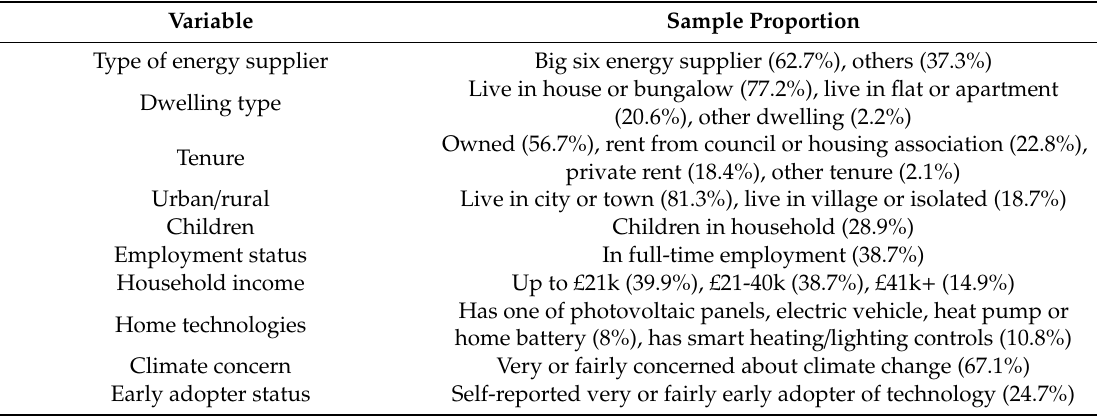
Table A2. Other variables recorded for the